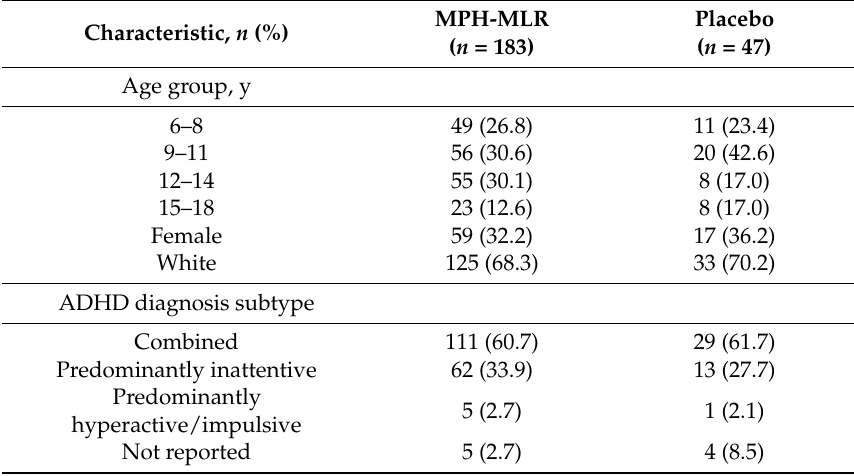
Table 1. Baseline demographic and clinical characteristics (safety population, n = 230).